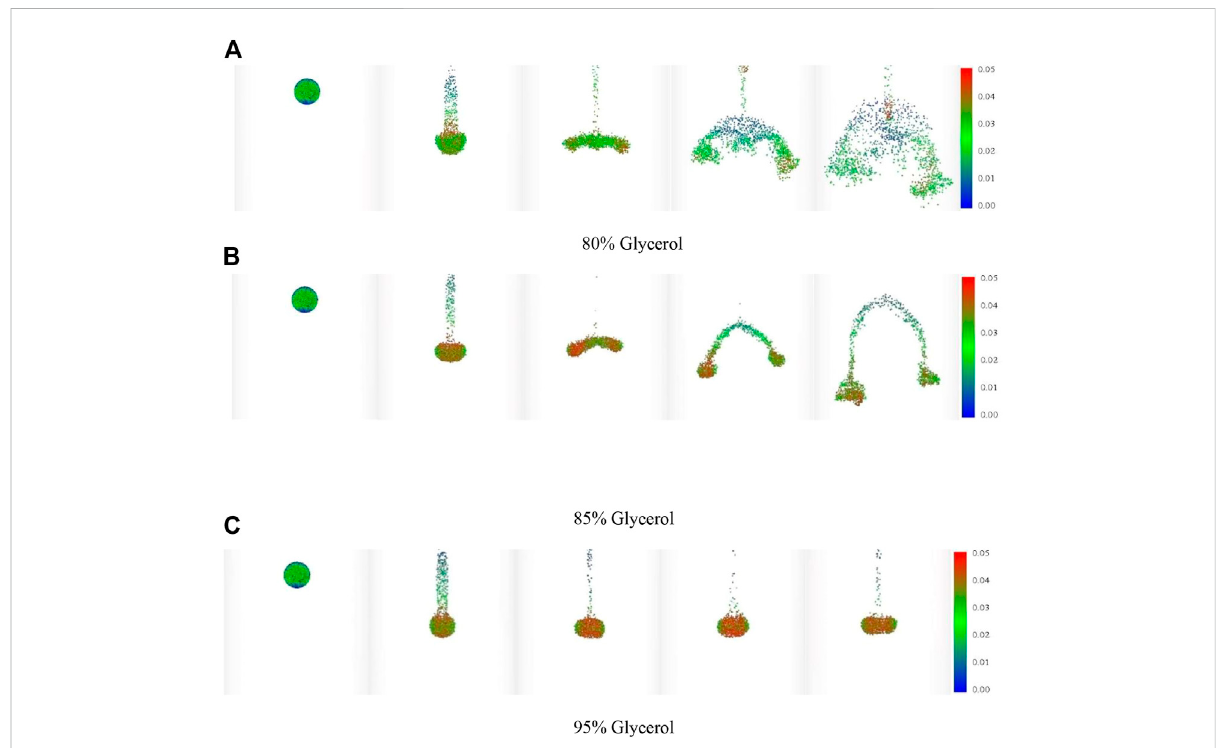
FIGURE 6 Particle velocity inside the cluster in glycerol (N = 5,000). (A) 80% Glycerol, (B) 85% Glycerol, (C) 95%